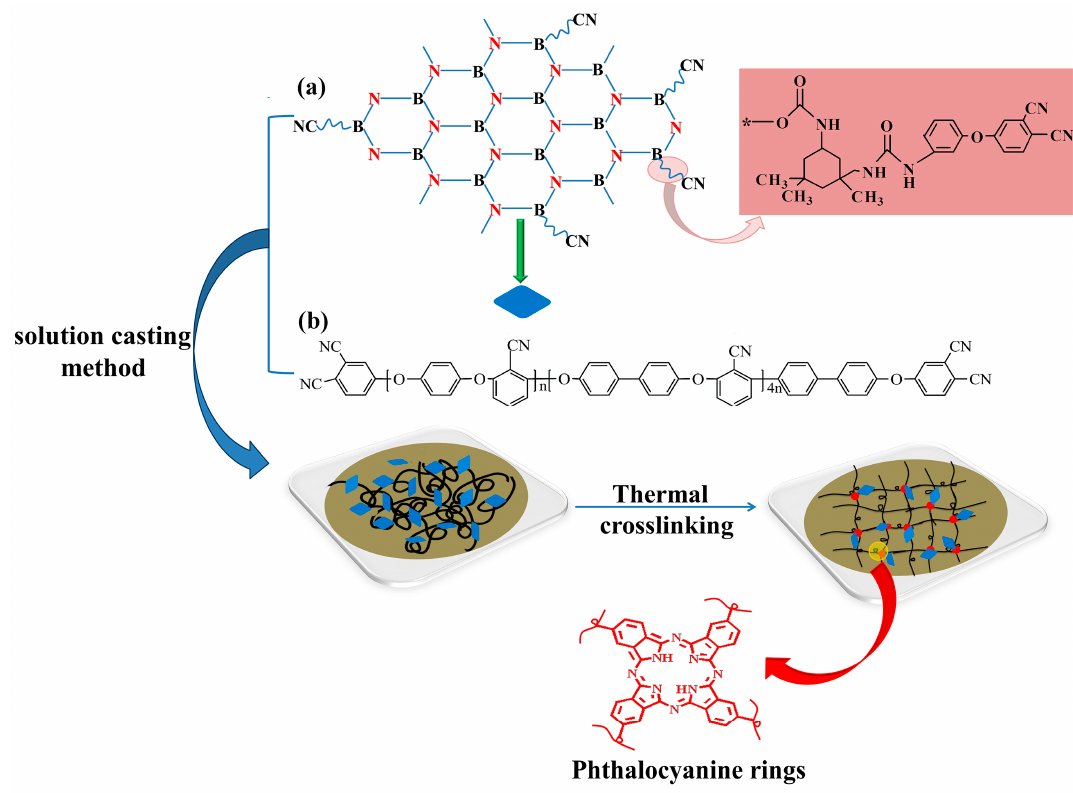
Figure 1. The synthetic route for the preparation of boron nitride and polyarylene ether nitrile hybrids (PEN-g-BN): ( a ) structure of phthalonitrile-modified BN (BN-CN); ( b ) structure of phthalonitrile end-capped PEN (PEN-Ph).